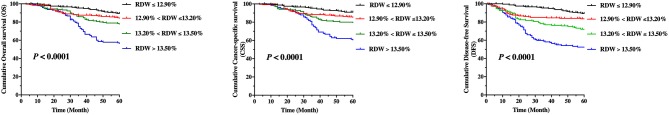
Kaplan–Meier curve stratified by red cell distribution width according to quartiles regarding overall survival (OS), cancer-specific survival, and disease-free survival (DFS) for patients with laryngeal squamous cell cancer.